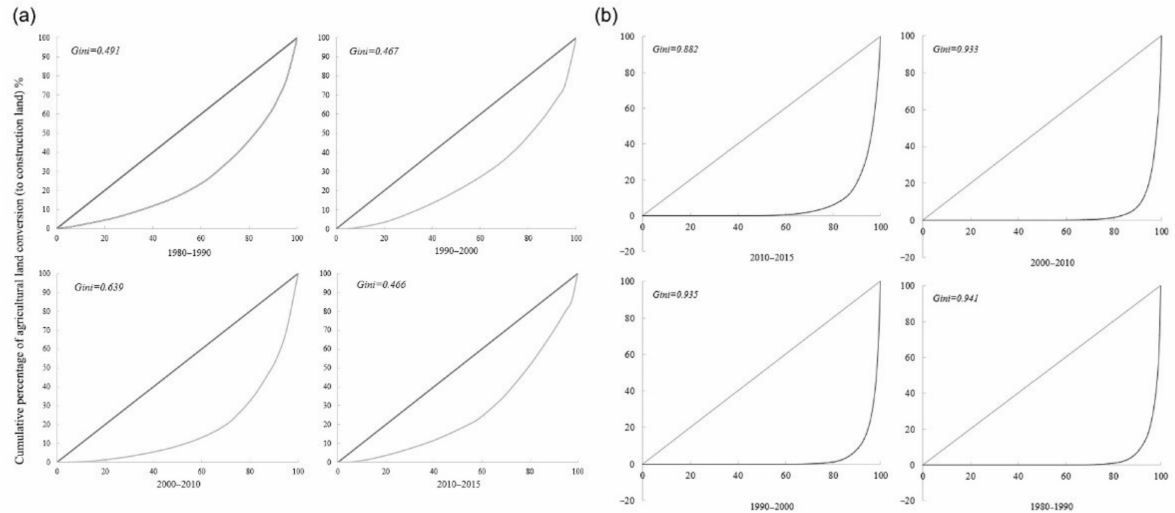
Figure 7. The Lorenz Curves of ACRa in Chongqing at ( a ) the county/district and ( b ) village level during 1980–1990.